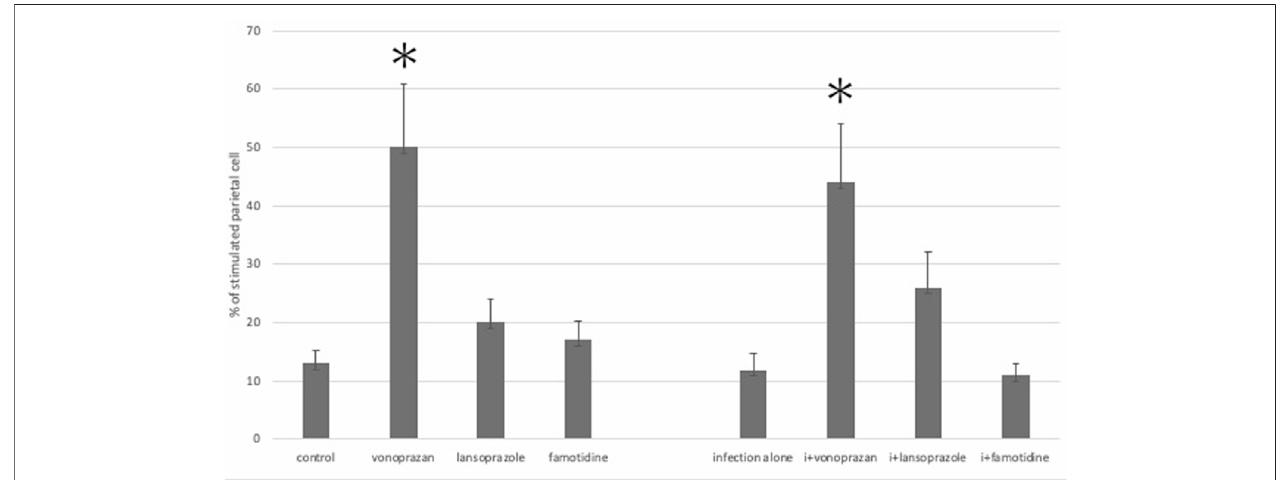
FIGURE 3 | Alteration of the parietal cell structure by acid suppressants and NHPH infection. No signi fi cant interaction was found between infection and acid suppressantsinthepercentageofthestimulatedparietalcell(F=1.54; p =0.224).Bythe posthoc analysis,thevonoprazan-treatedgroupshowedasigni fi cantincrease in the stimulated parietal cell in both non-infection and infection groups ( p < 0.05).